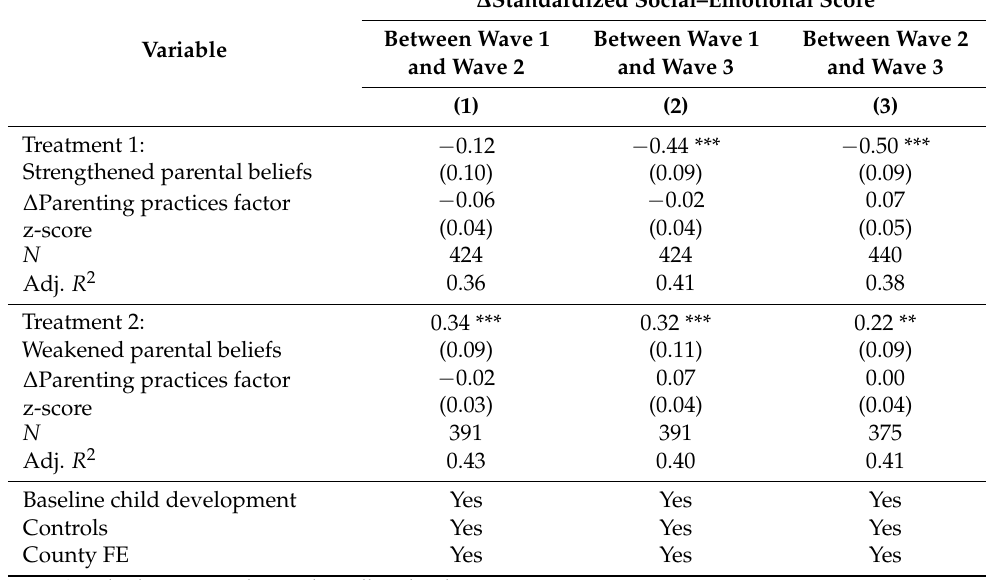
Table 6. Mediation analysis of impact of parental beliefs on child social–emotional development through parenting